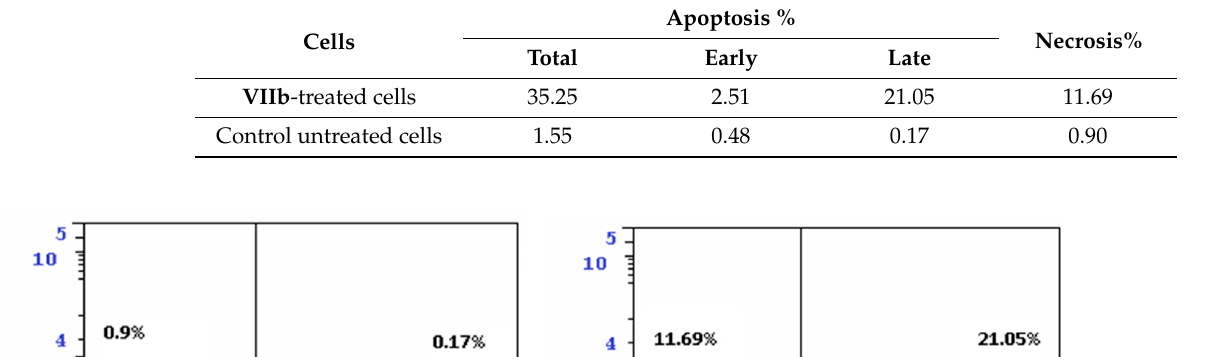
Table 5. Percentage of apoptotic cells after Compound VIIb treatment. Apoptosis % Cells